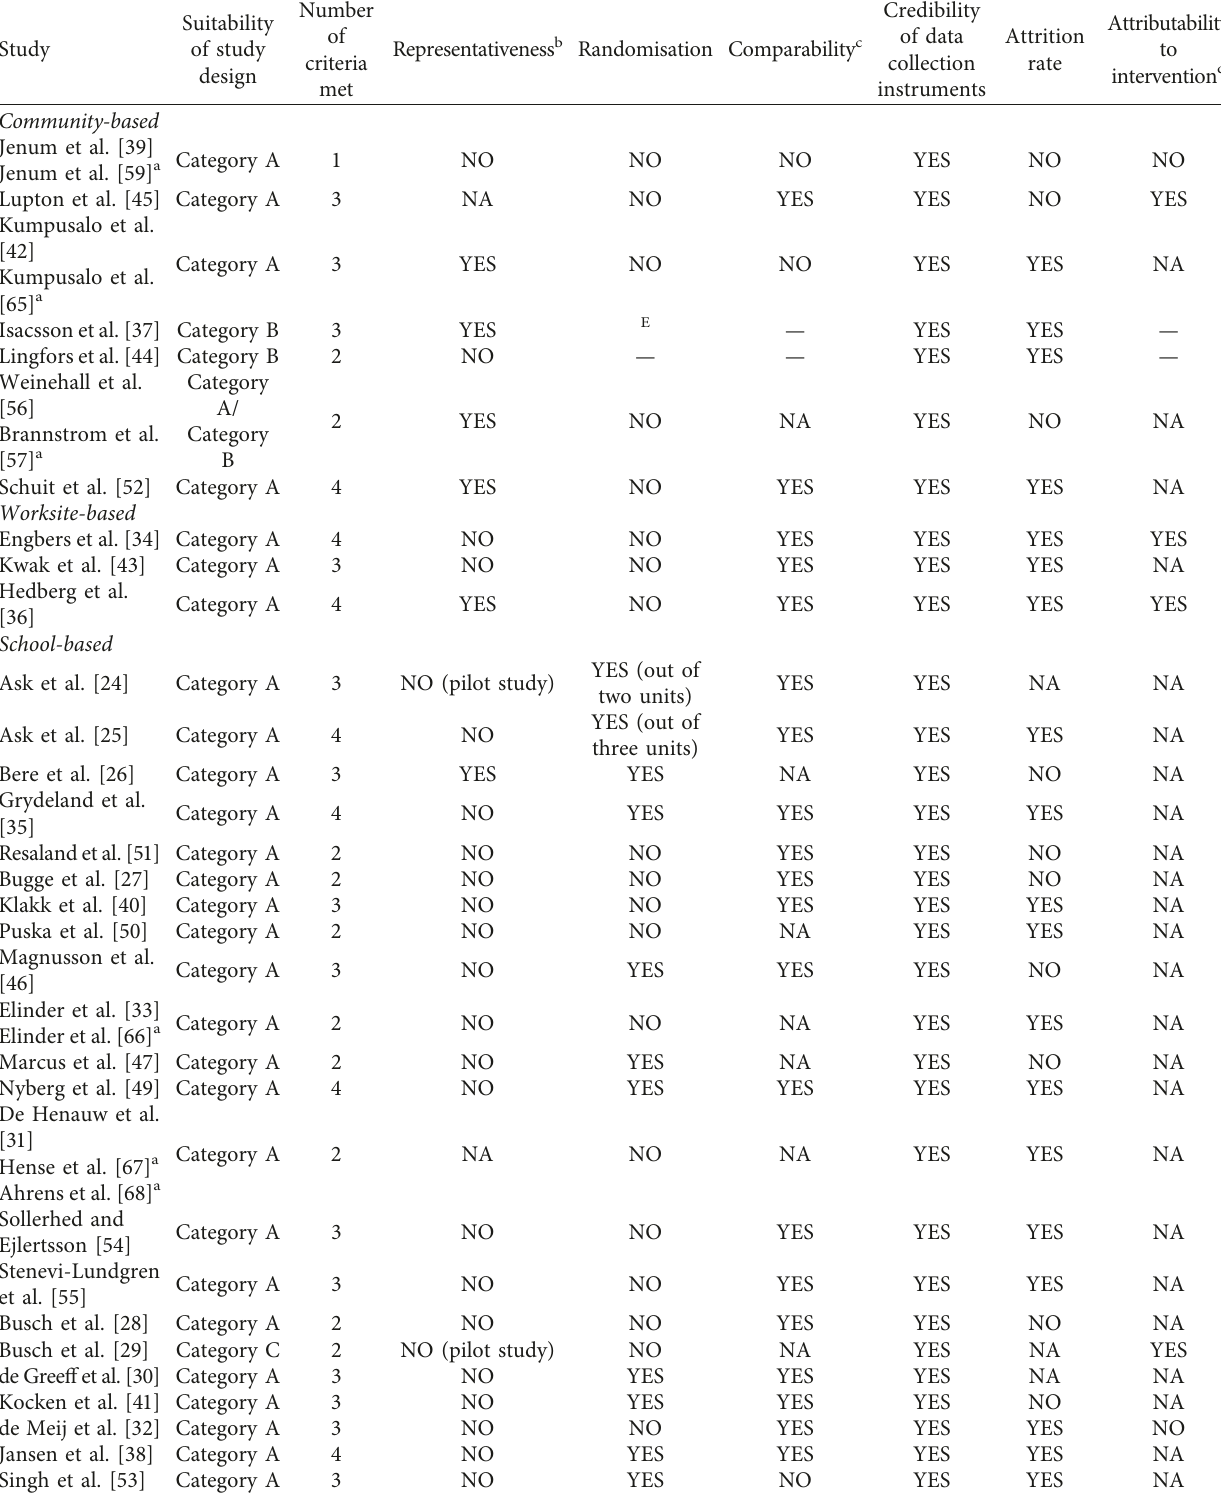
Table 4: Quality assessment of setting-based